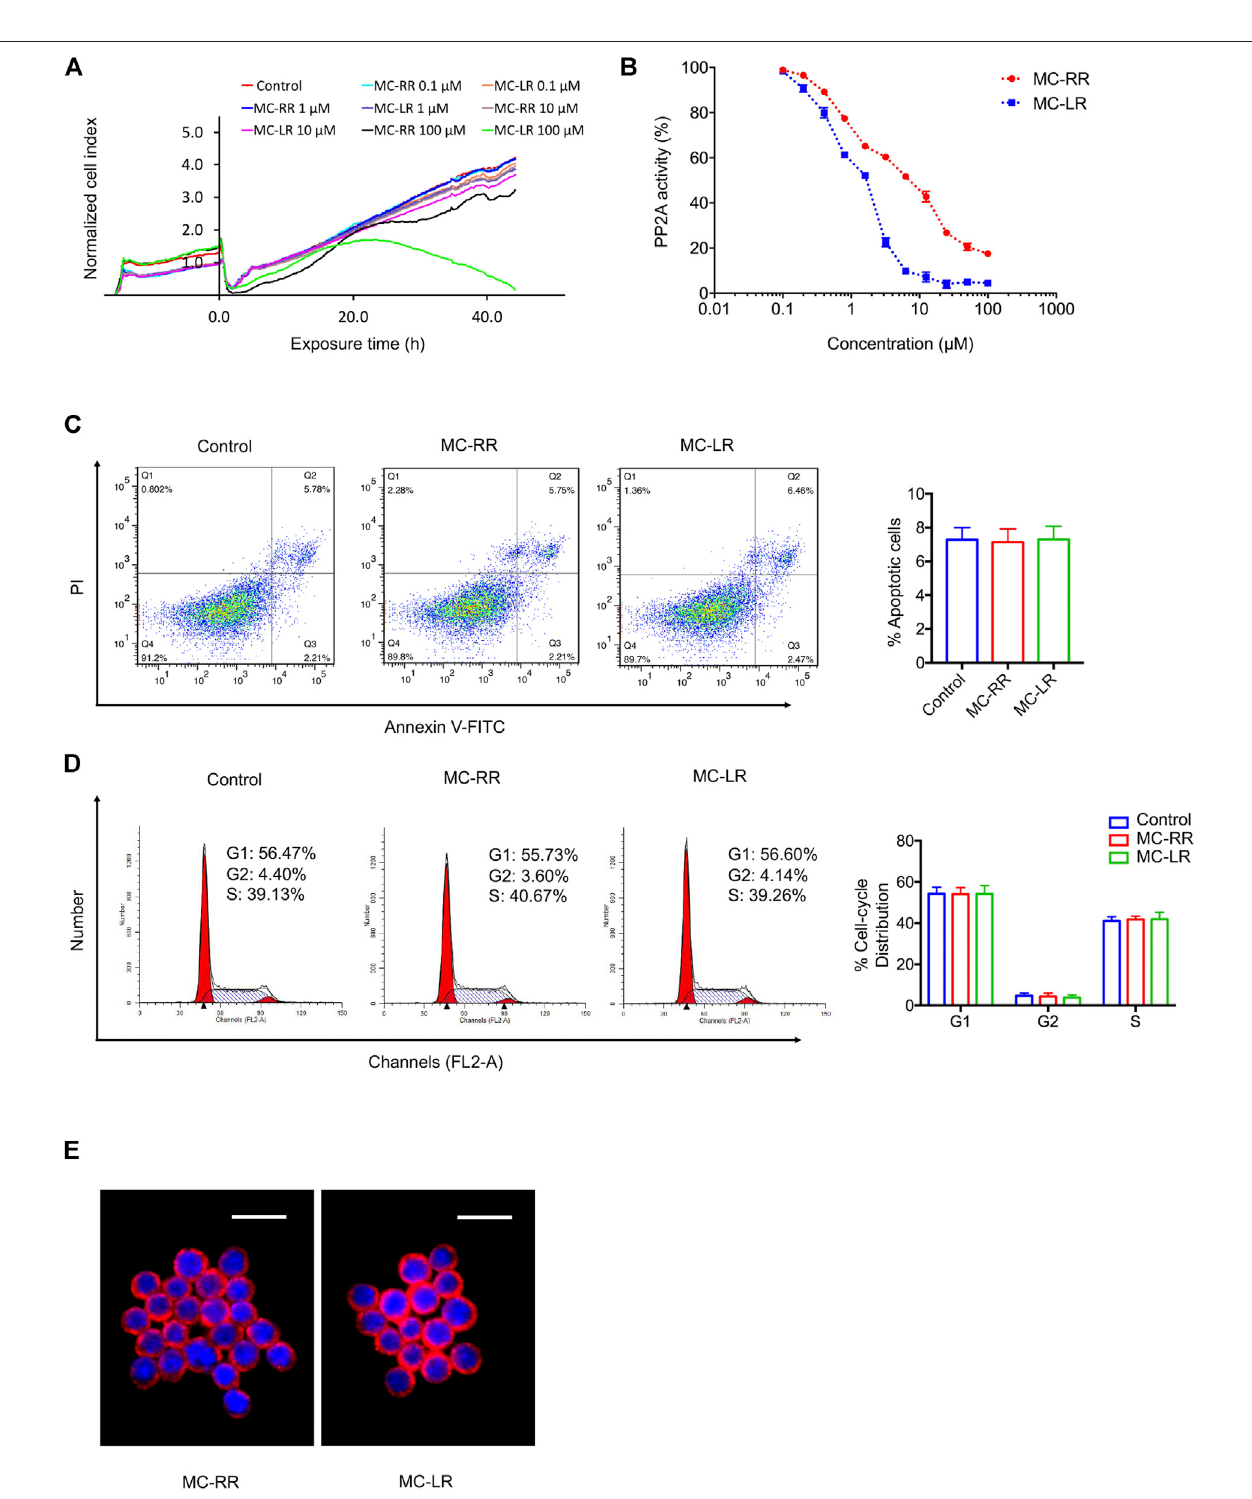
FIGURE6| Microcystin-RR(MC-RR)showslowertoxicitythanMicrocystin-LR(MC-LR). (A) HumannormallivercelllineL02susceptibletoMCswasexposedto0, 0.1, 1, 10, and 100 μ M MC-RR or MC-LR for 48 h. L02 cell yield was continuously monitored by the xCelligence real-time cell analyzer (RTCA). The cell indices were normalized to re fl ect the cell growth relative to the values at initial exposure. (B) Alterations in protein phosphatases 2A (PP2A) activity were measured in L02 cells exposed to different concentrations of MC-RR or MC-LR. The activity is expressed as the percentage of PP2A activity in extracts from untreated cells. (C,D) RAW264.7cellswereculturedwith0.1 μ MMC-RRorMC-LRfor48 h.Cellcycleandapoptosiswasmeasuredby fl owcytometry.Dataarepresentedasmean ± SD. (E) The uptake of MC-RR or MC-LR by macrophages was detected by immuno fl uorescence. DAPI was used for nuclear staining (blue). Scale bar: 20 μ m.